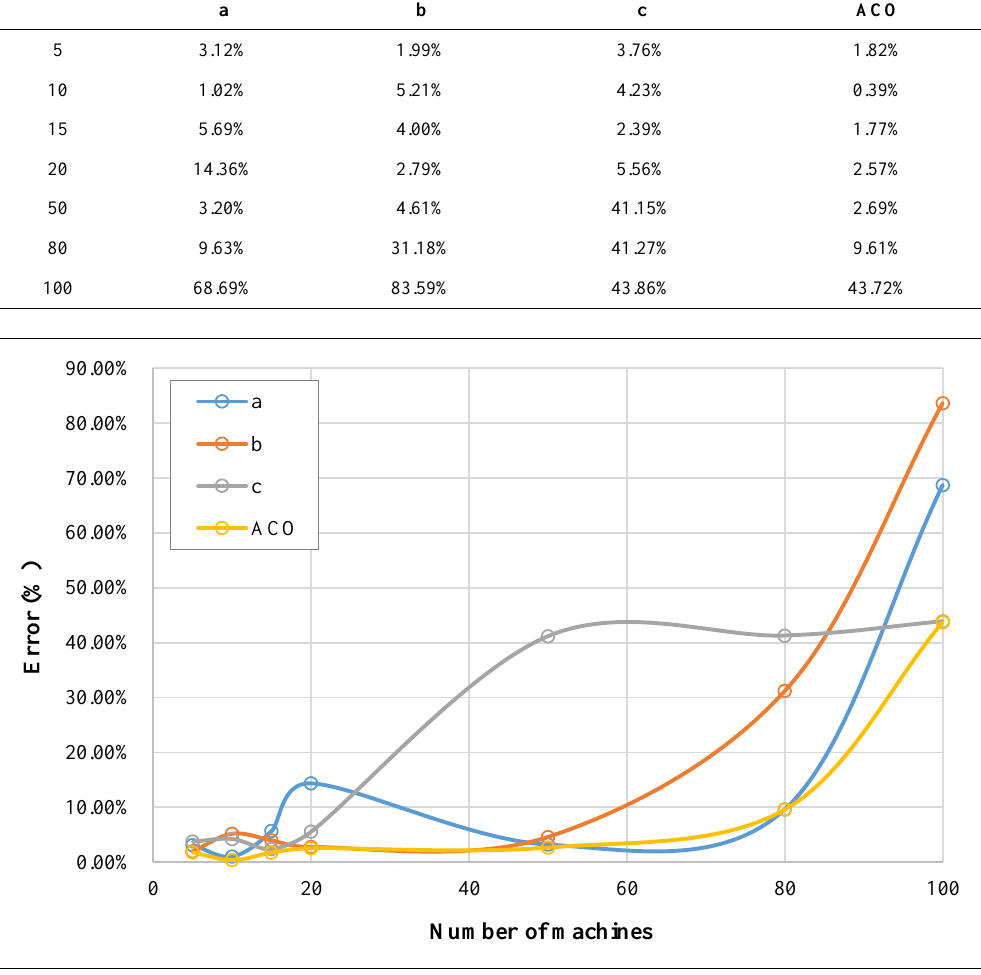
Figure 4. The error rate for the mode of